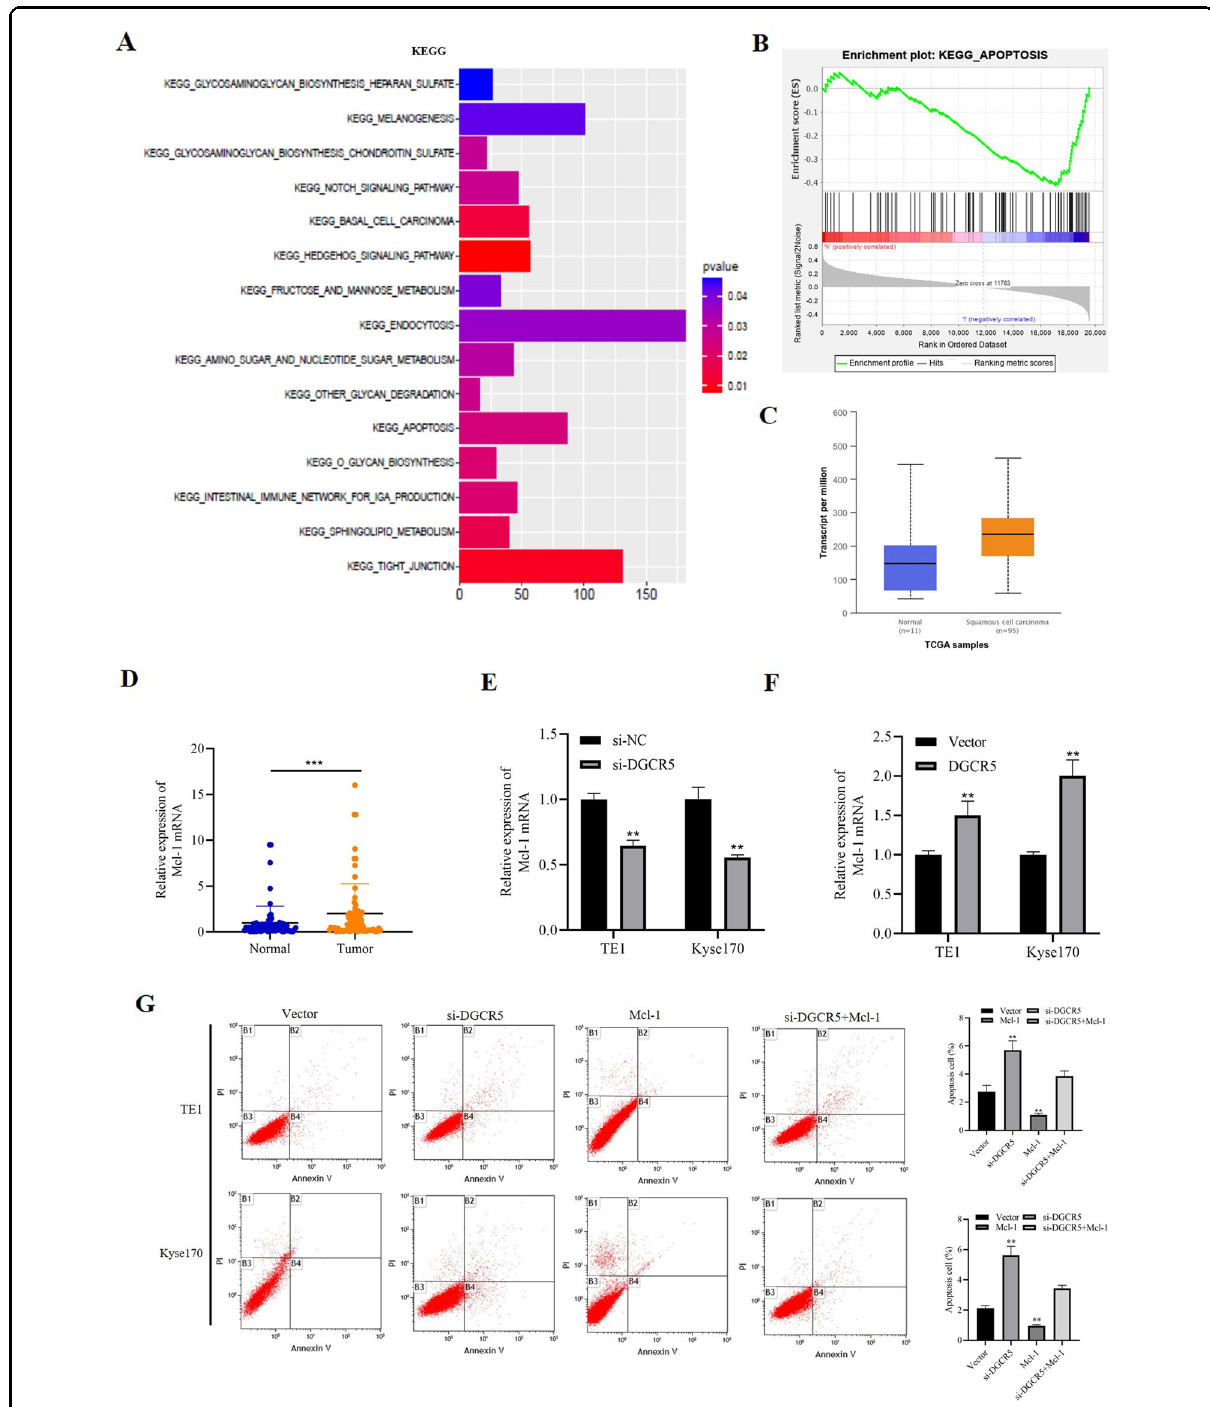
Fig. 4 DGCR5 promotes antiapoptotic gene Mcl-1 expression in ESCC. A Kyoto Encyclopedia of Genes and Genomes (KEGG) pathway of DGCR5 ‑ related ESCC genes. Fisher exact P values were plotted for each enriched functional category. Enriched functional categories with P < 0.05 are shown. B GESA enrichment of the subsets of DGCR5 ‑ related genes involved in apoptosis. C Mcl-1mRNA was upregulated in ESCC tissues according to the TCGA database. D Mcl-1 mRNA was increased in the 70 pairs of ESCC samples. E Mcl-1 mRNA was inhibited when DGCR5 knockdown in TE1 and Kyse170 cells. F Mcl-1 mRNA was upregulated when DGCR5 overexpressed in TE1 and Kyse170 cells. G Knockdown of DGCR5 promoted cell apoptosis while Mcl-1 overexpression inhibited apoptosis in TE1 and Kyse170 cells, but simultaneous knockdown DGCR5 and Mcl-1 overexpression could reverse it. * P < 0.05 and ** P < 0.01.